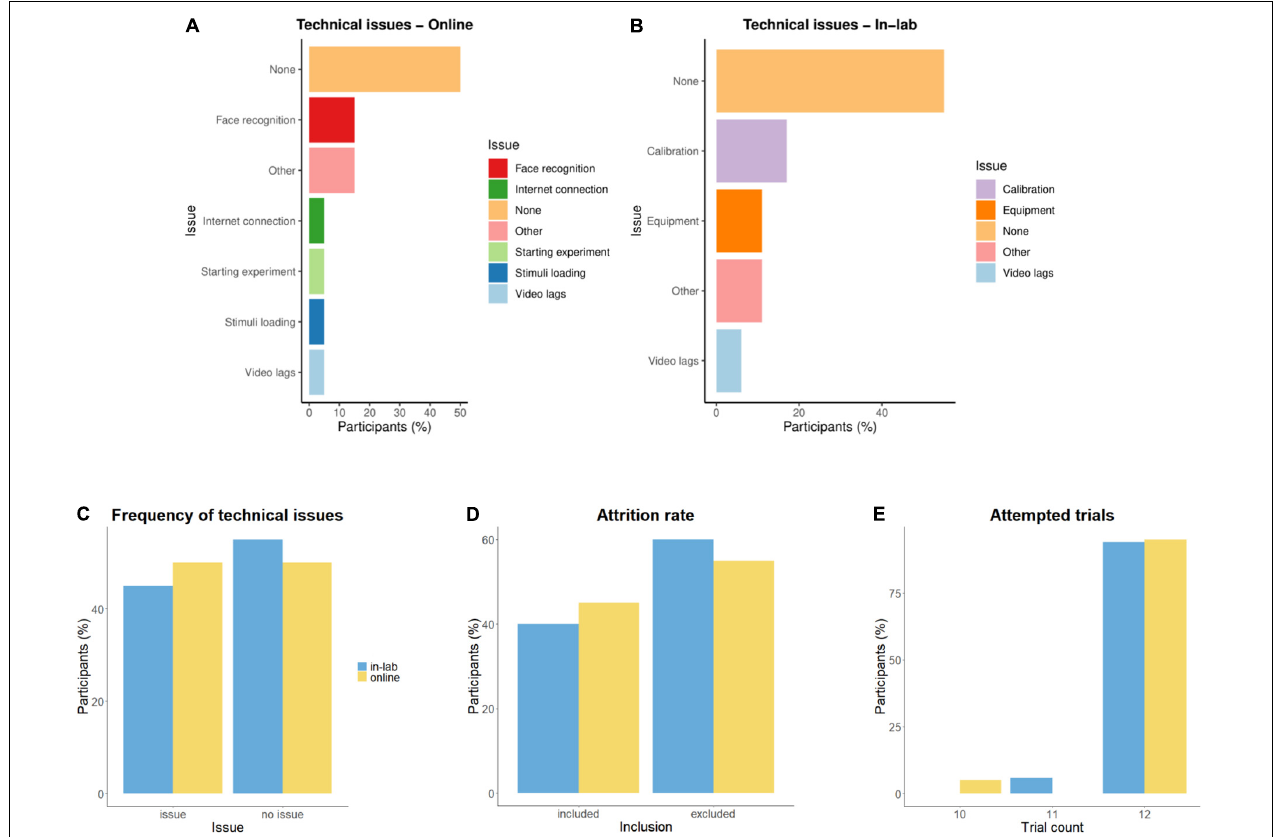
FIGURE 5 | Comparison of feasibility to participate in the laboratory and online, reflected in (A,B) technical issues; (C) frequency of technical issues; (D) attrition rate; and (E) number of attempted trials.